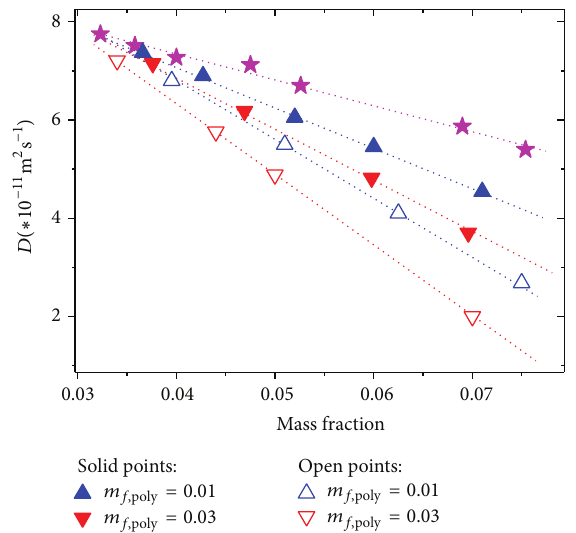
Figure 2: The collective diffusion of a mixture of C 12 E 5 microemul- sion with PCL at constant droplet mass fraction (0.2) and /𝑚 𝑚 = 1.08. The solid points are a mixture of C 12 E 5 with PCL Dec C 12 E 5 with M.W. = 5000 and different polymer mass fractions and open points are a mixture of C 12 E 5 microemulsion with PCL with M.W. = 10000 and polymer mass fraction.